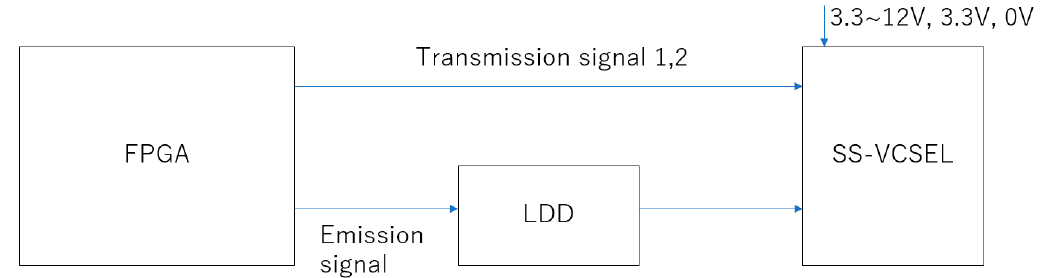
Figure 6. Block diagram of the Tx module.